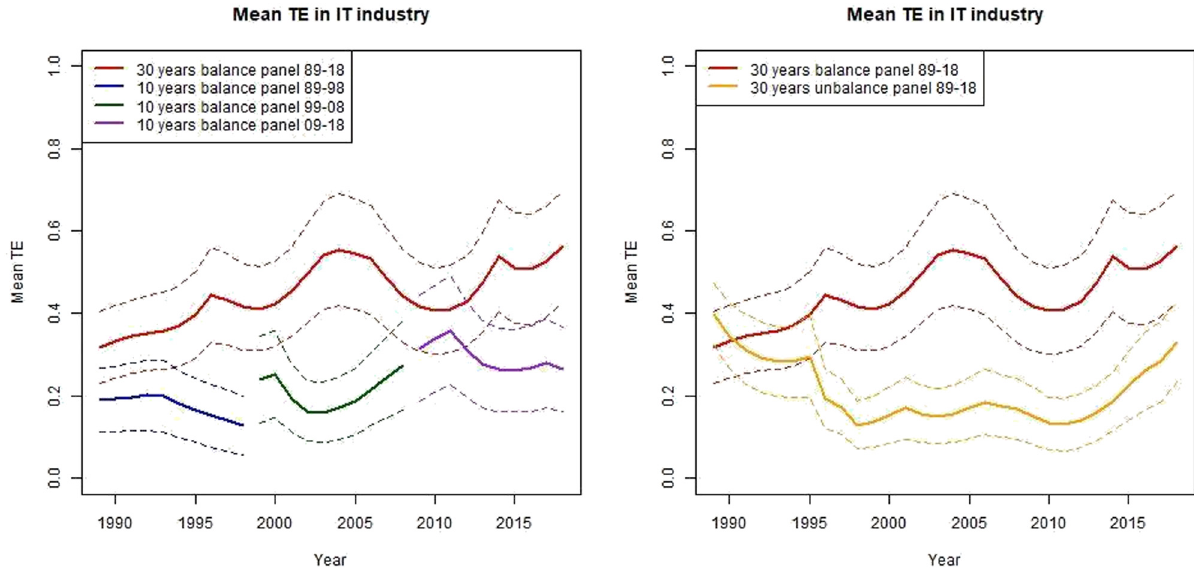
Figure 3: Mean TE in the IT